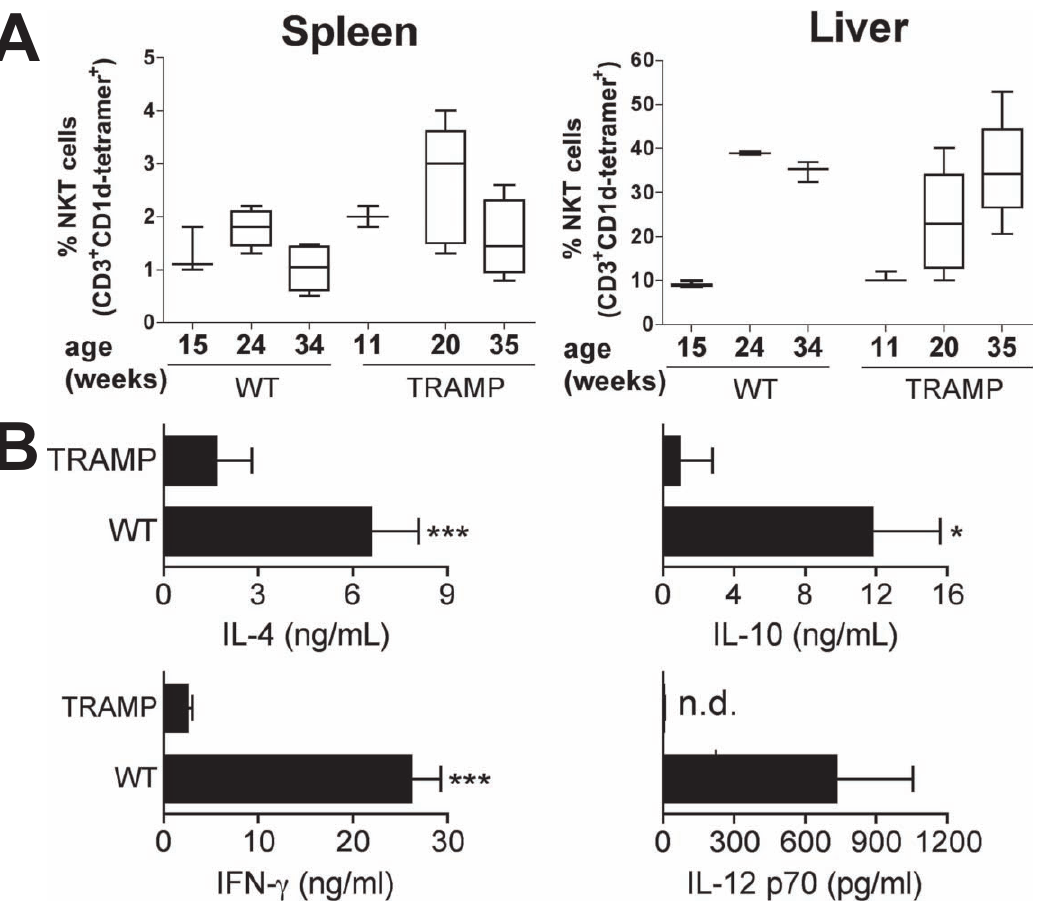
Figure 1. Tumor-bearing TRAMP mice exhibit defective cytokine production in vivo by iNKT cells and DC, albeit harboring normal iNKT cell frequencies. A. Cell suspensions of spleens and livers of WT and TRAMP mice were stained with mAbs against CD3, NK1.1 and PBS-57- loaded CD1d tetramers and analyzed by FACS, identifying comparable numbers of iNKT cells. (n=5). B. TRAMP mice or age-matched C57Bl/6 mice were injected with a -GalCer. Mice were sacrificed 90 min (IL-4, IL-10) and 300 min later (IFN c , IL-12 p70) and cytokines determined by ELISA. (*, p,0.05, ***, p , 0.001, n.d, not detectable, n=3).